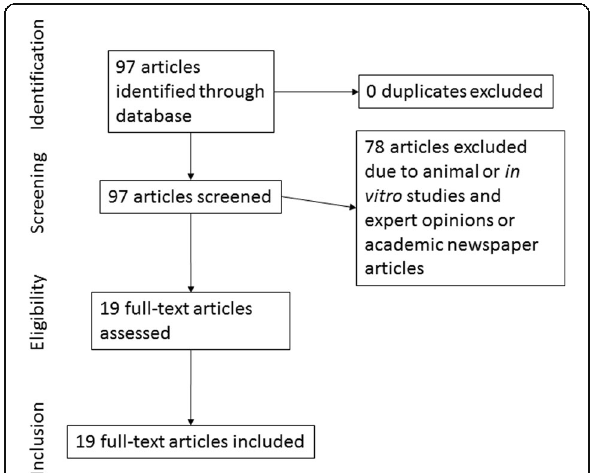
Fig. 2 The flow chart of the search strategy of the international literature